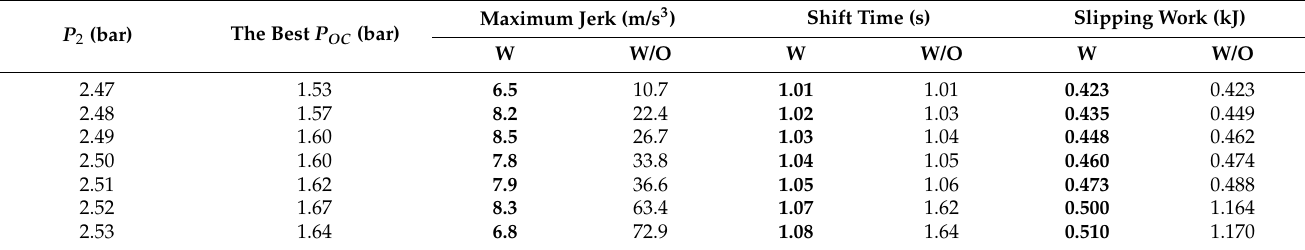
Table 3. The best P OC and the shift indexes under different P 2